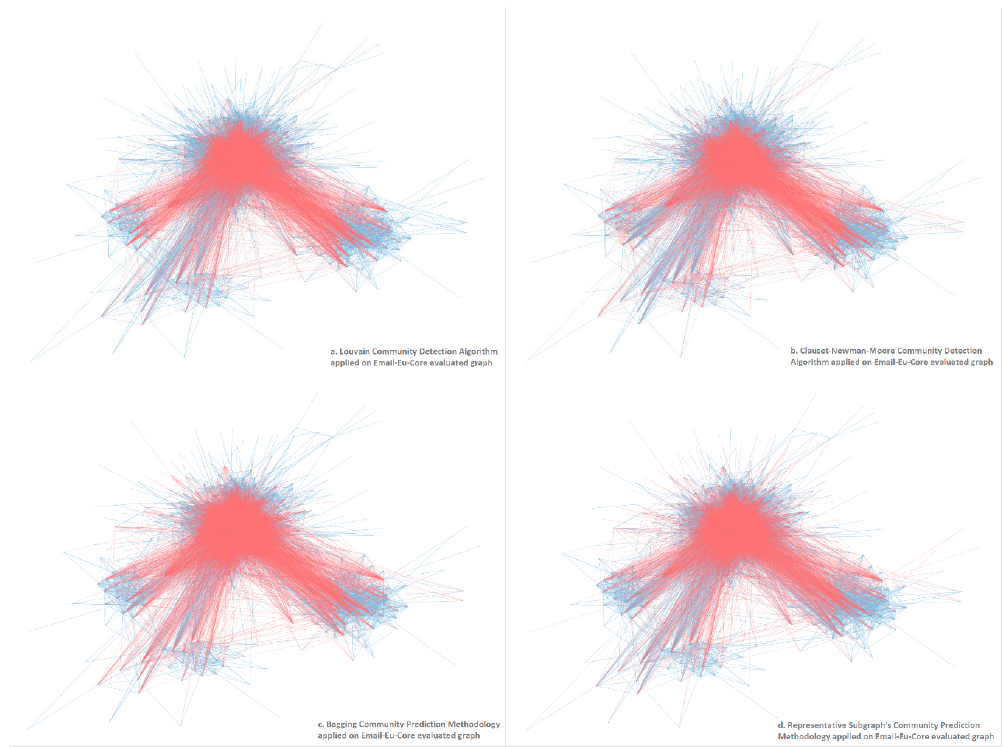
Figure 4. Graphical comparison of the different generated community structures for the Email-Eu-Core [30] social graph per each method applied. ( a ) Louvain community detection algorithm [10,25]; ( b ) Clauset–Newman–Moore community detection algorithm [3,25]; ( c ) bagging community prediction methodology; ( d ) representative subgraph’s community prediction methodology [4]. In this figure, by representing the inter-connection edges with the red and the corresponding intra-connection edges with the blue colored edges, displays the community structure unveiled by: